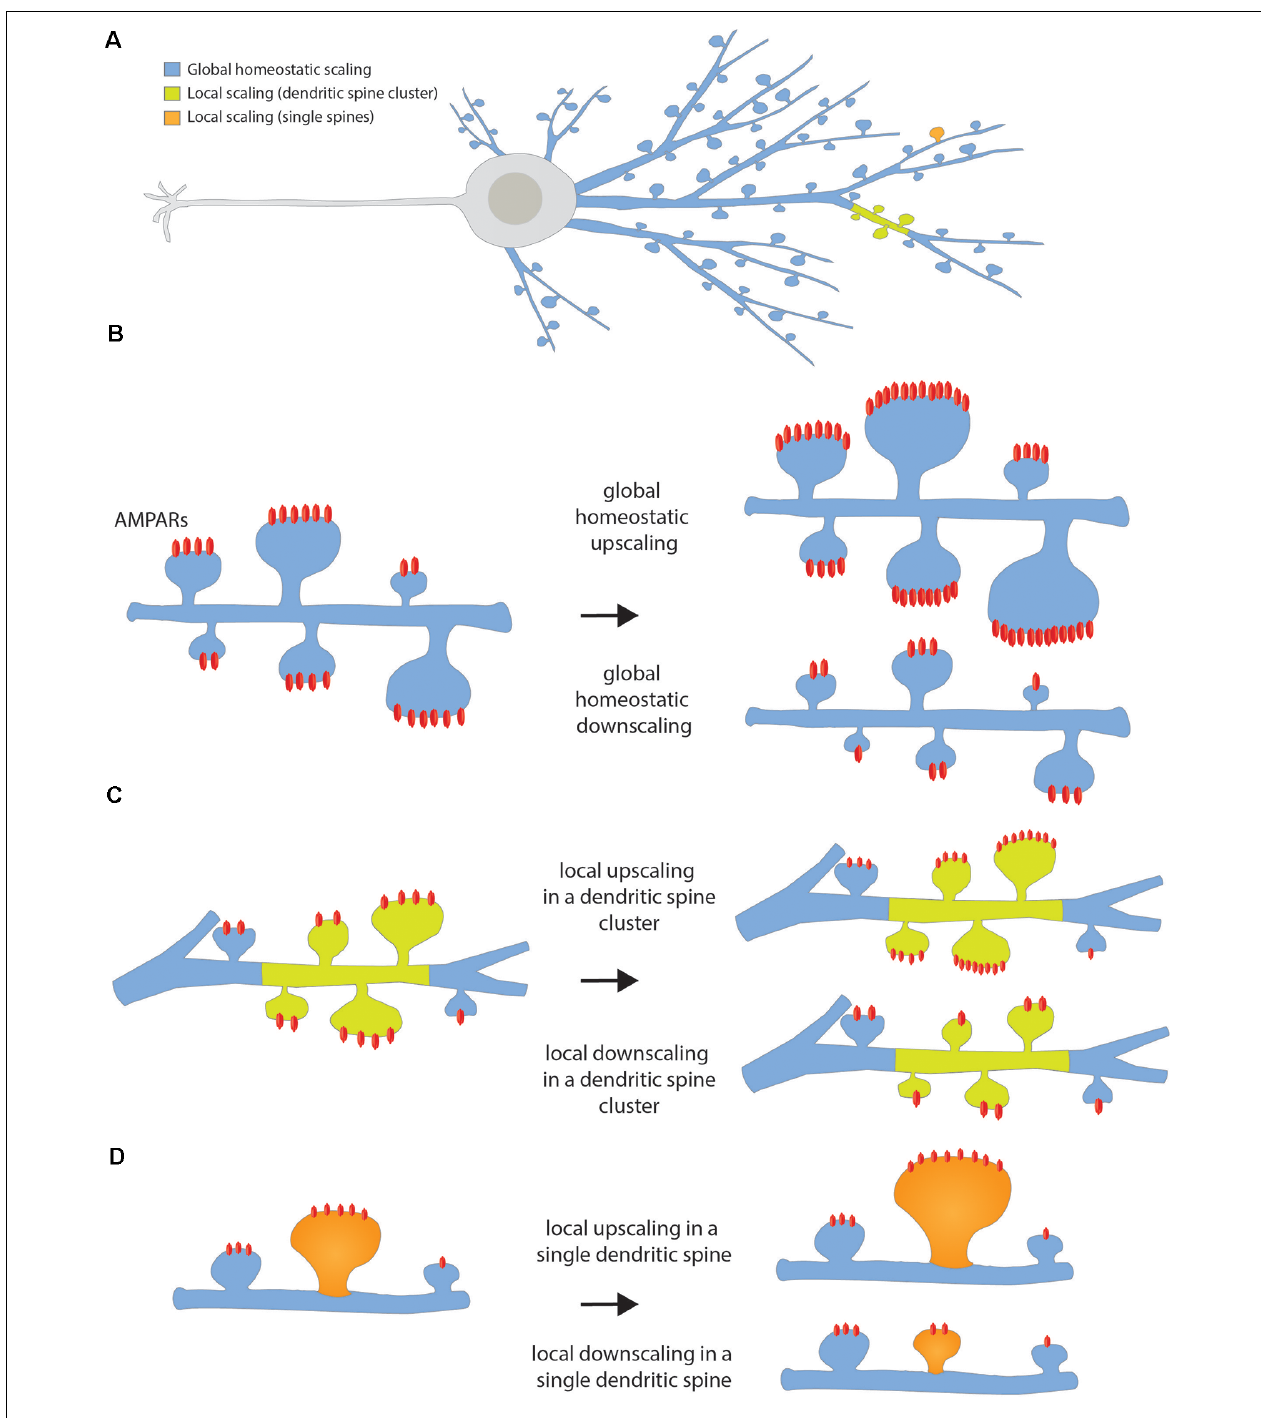
FIGURE 2 | Homeostatic synaptic scaling. (A) Scheme of the whole neuron showing the color code for the different types of homeostatic scaling depending on the extent of the changes. (B) Global homeostatic up- or downscaling happens at the network level after a period of lowered or elevated firing rate, respectively. The neuron senses its own firing rate and it increases or decreases the strength of all its dendritic spines in a multiplicative manner, in such a way that the differences between synaptic weights are preserved. (C) Local up- or downscaling at the level of dendritic segments happens when a group of neighbor spines forming a cluster undergoes an increase or decrease in synaptic strength independently of the spines located in the neighbor dendritic segment. (D) Local up- or downscaling can also happen at the level of single dendritic spines when individual spines are able to autonomously sense their level of activity and compensate for it by increasing or decreasing its synaptic